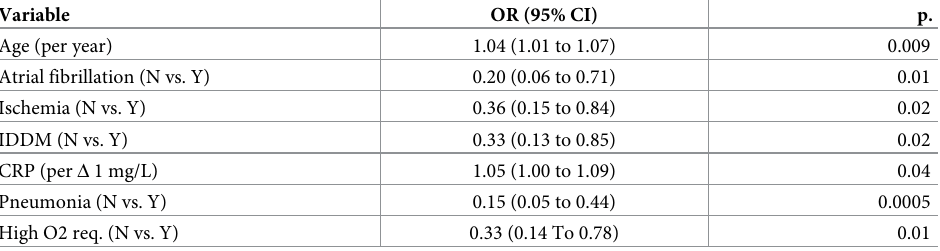
Table 2. Variables predictive of in-hospital, any-cause mortality in univariate testing in the Derivation Cohort of patients.